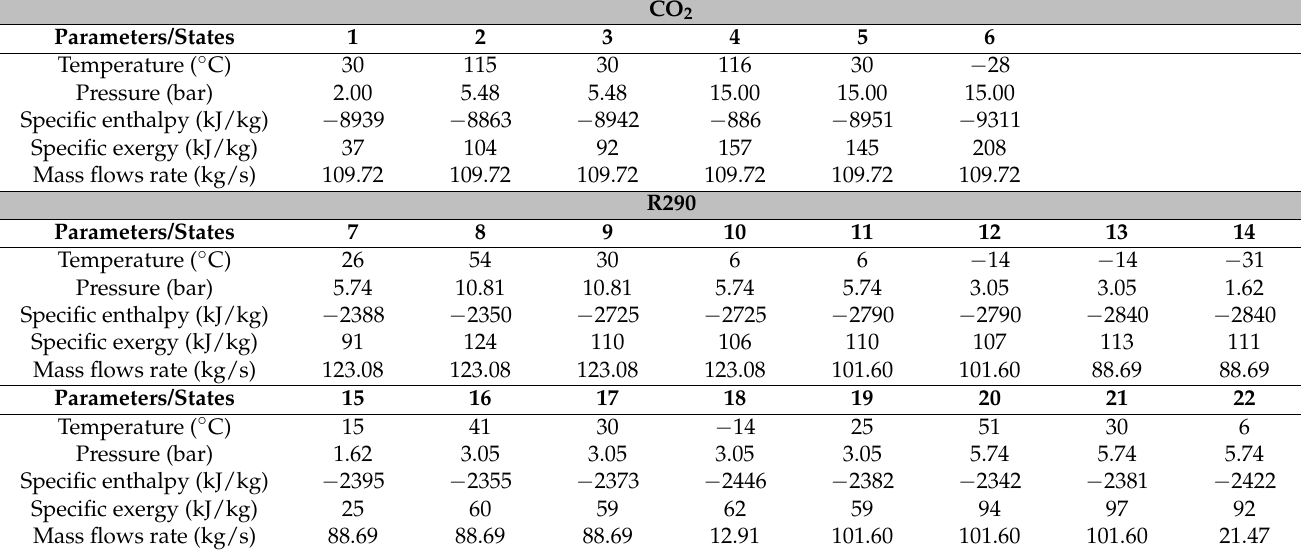
Figure 4. Three-stage vapor-compression CO 2 liquefaction process. Figure 4. Three ‐ stage vapor ‐ compression CO 2 liquefaction process. Table 1. The simulation result of three-stage vapor-compression CO 2 liquefaction process (Figure Table 1. The simulation result of three ‐ stage vapor ‐ compression CO 2 liquefaction process (Figure 4).